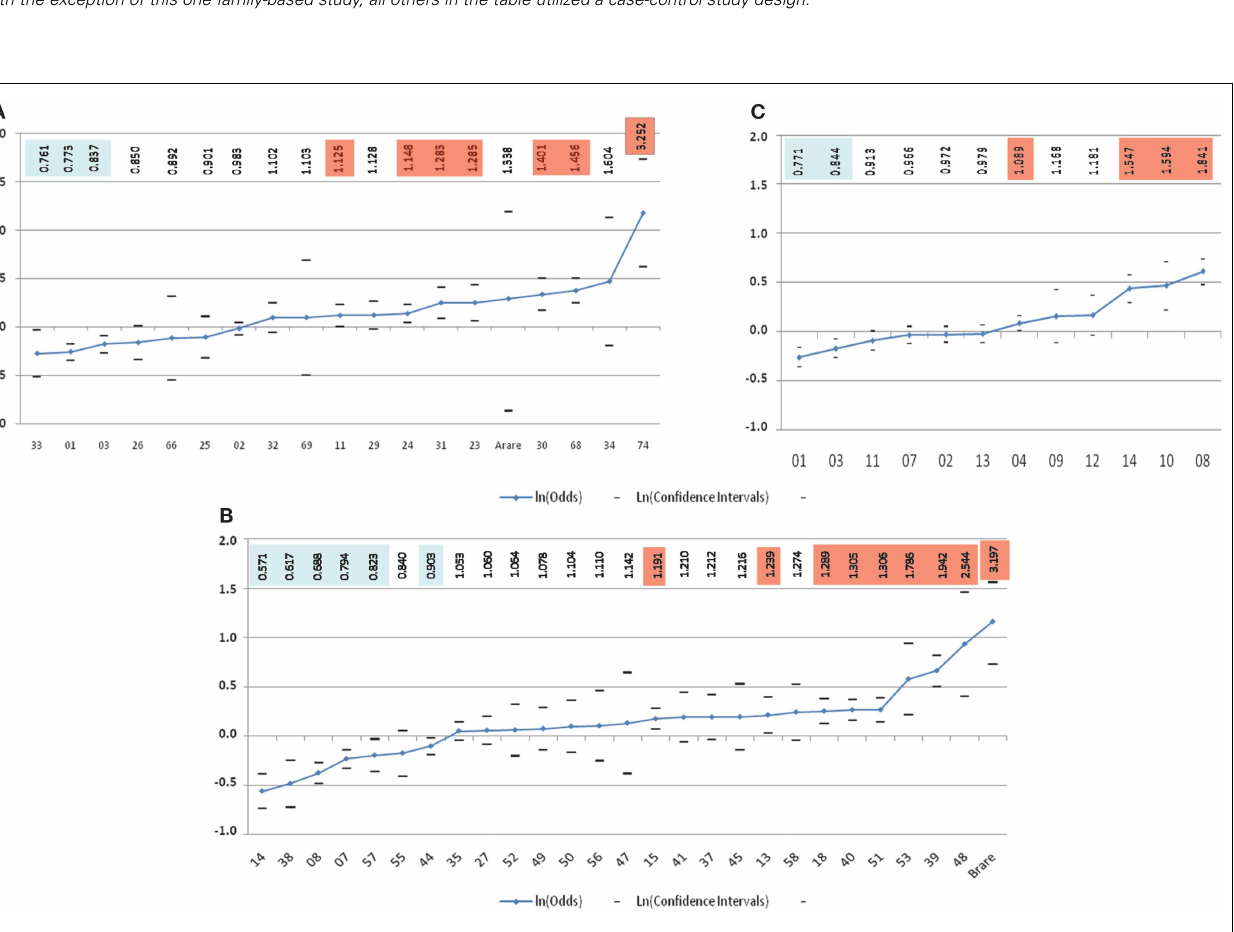
FIGURE 2 | Risk of medically refractory childhoodALL according to 2-digit HLA alleles at HLA-A (A), HLA-B (B), and HLA-DRB1 (C) (24) .The vertical scale is in ln(Odds) with odds values listed alone the top highlighted in blue for favorable and orange for predisposing-allele.